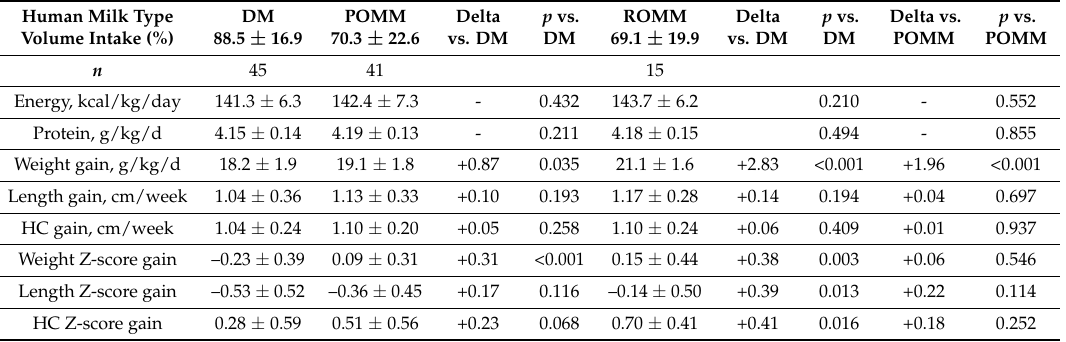
Table 4. Growth rate and nutritional intakes according to the main human milk type received during the study